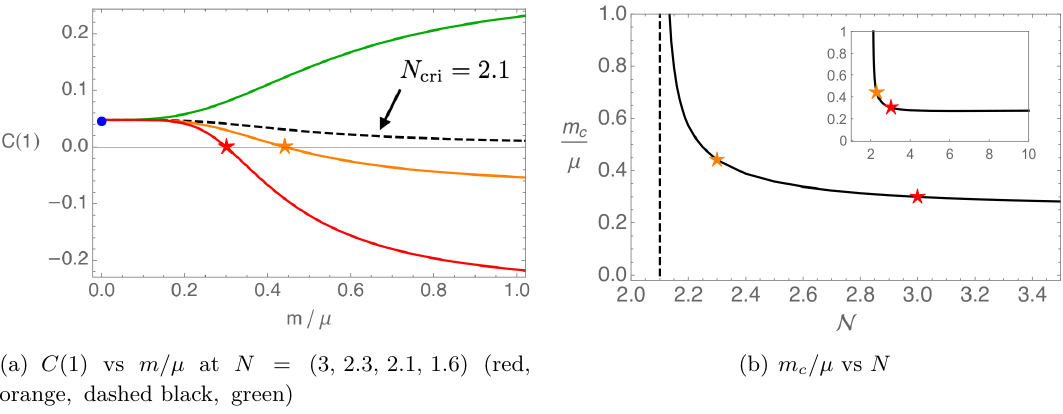
Figure 8 . Checking the area theorem at T = 0 with m/µ . Blue dot in figure 8(a) is the same as in figure 3(b). The stars represent m c /µ and the black dashed lines are the data at N cri .